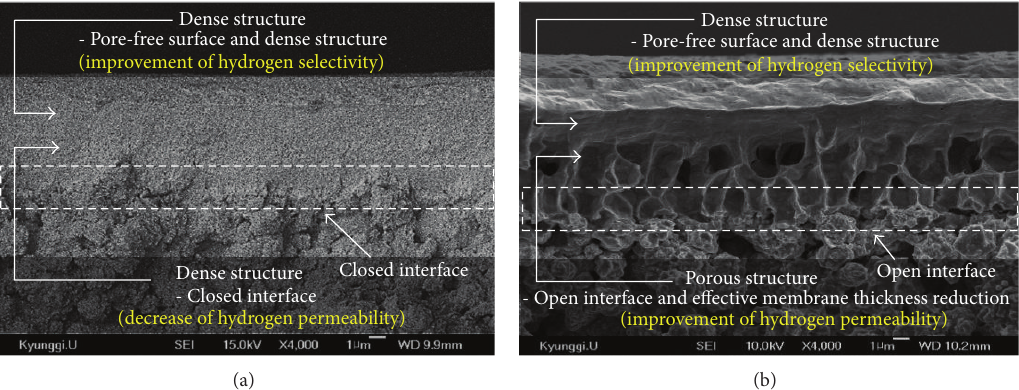
Figure 5: The cross-sectional FE-SEM images of (a) purely dense structured and (b) dense/porous hybrid structured Pd-Cu alloy films.